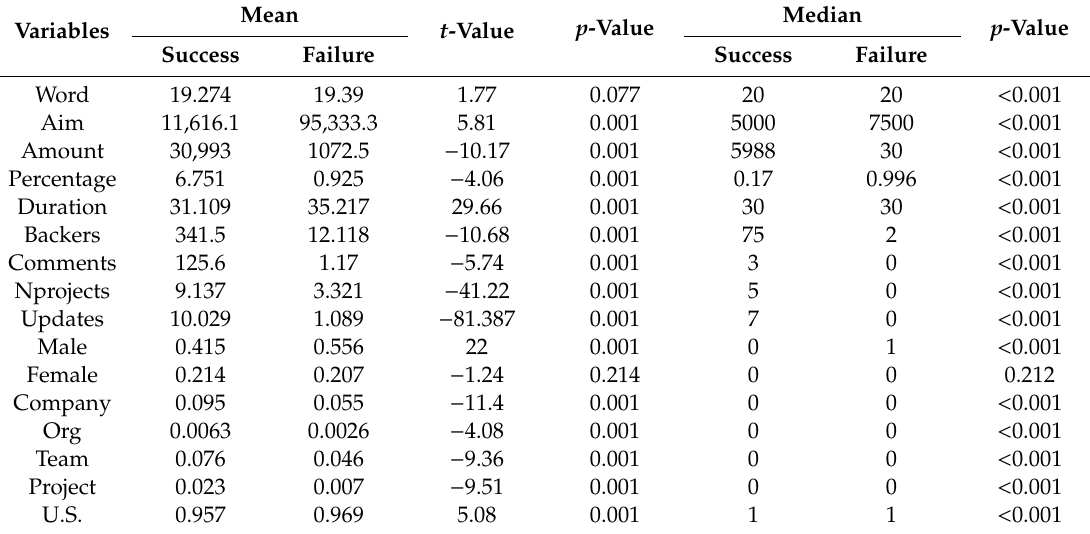
Table 5. Univariate analysis. This table provides the univariate analysis of the mean and the median di ff erence between variables used in this study. Table 3 defines all the